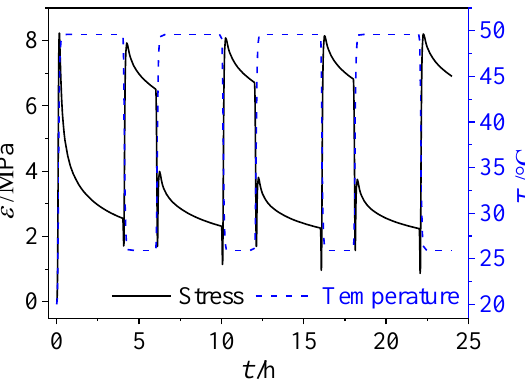
Figure 9. Temperature and the stress data at the connections between the key solder joint and the silicon chip. ( P max = 5 × 10 7 W·m −3 , P min = 1 × 10 7 W·m −3 , and t trans = 600